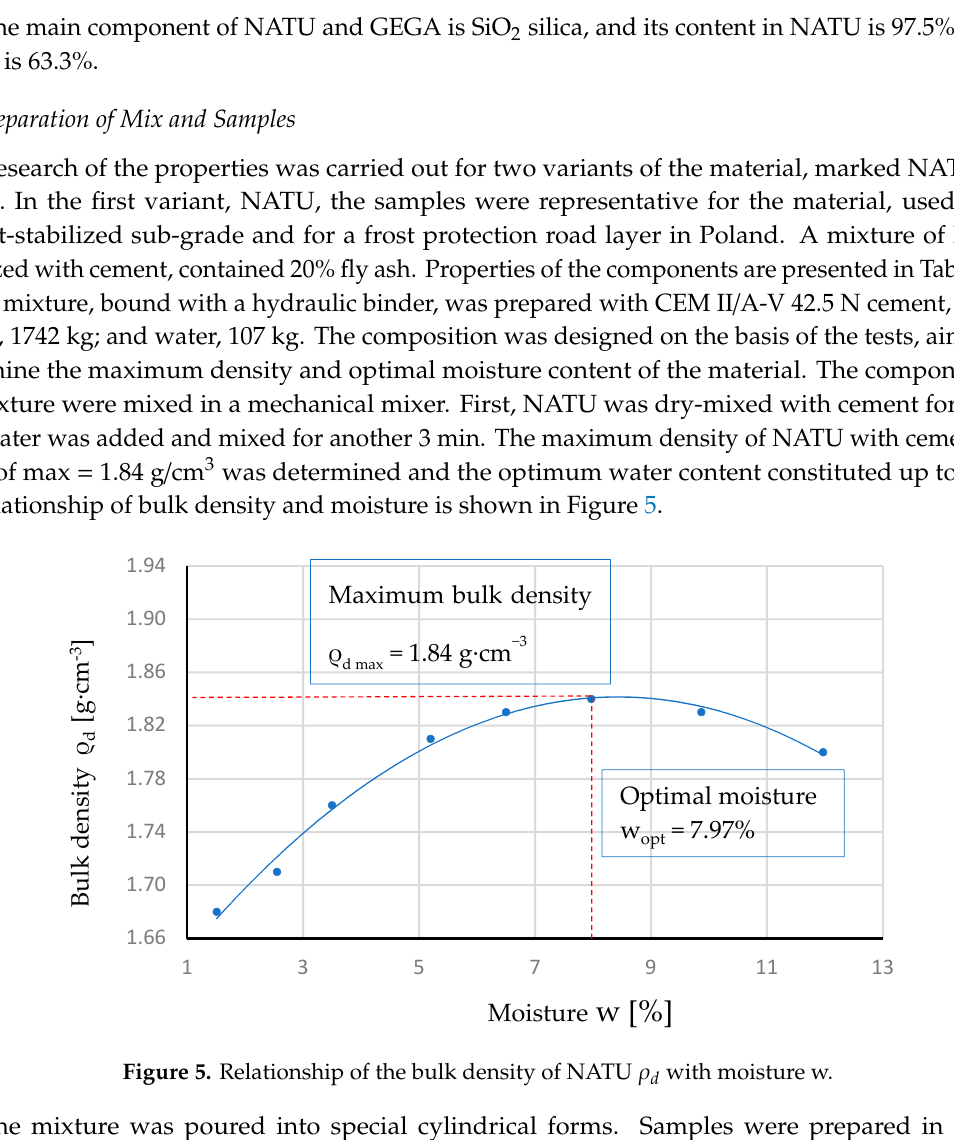
Figure 5. Relationship of the bulk density of NATU ρ d with moisture w.